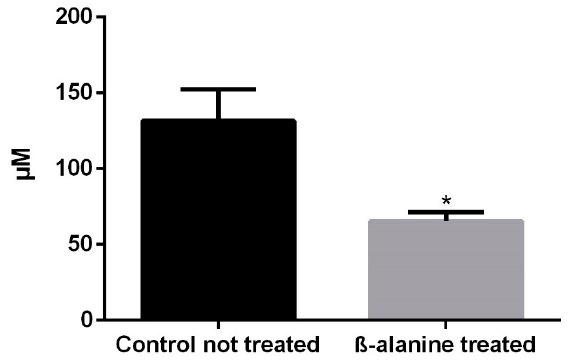
Figure 1. Taurine plasma levels in control and taurine depleted animals. Two months of treatment with β -alanine caused a significant reduction of the taurine plasma levels ( n = 4, each subgroup). * = Statistically significant ( t -test, p < 0.0001).